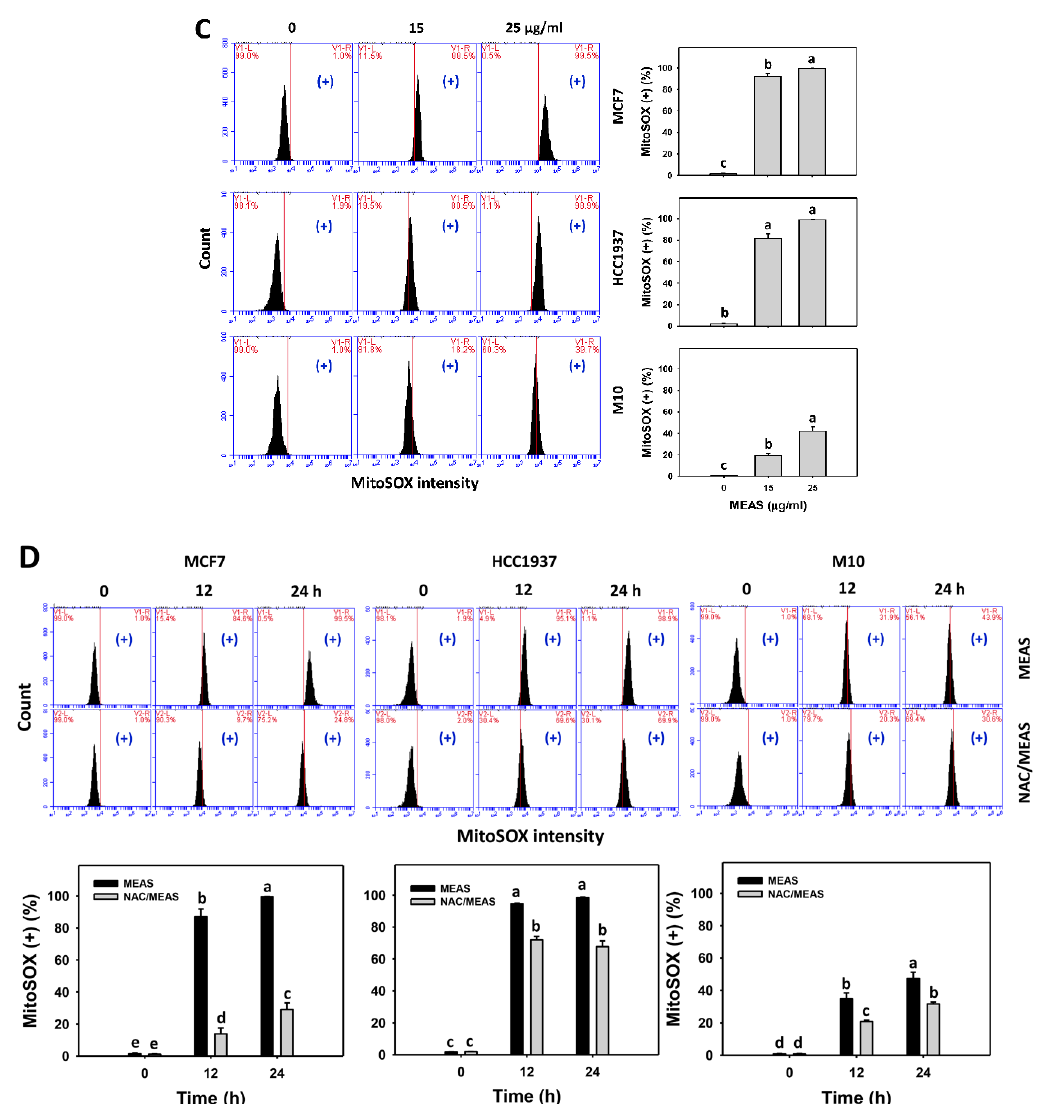
Figure 6. MEAS increased ROS and MitoSOX intensities of breast cancer cells. ( A , C ) ROS and MitoSOX assays of MEAS. Except for normal breast cells (M10), others were TNBC and non-TNBC cells. Flow cytometry was performed after 24 h drug treatment. (+), inserted within each panel, indicates the ROS and MitoSOX (+) intensity. ( B , D ) ROS and MitoSOX assays o f NAC/MEAS. NAC/MEAS represents NAC pretreatment (10 mM, 1 h) and MEAS posttreatment for 0, 12, and 24 h. Data = mean ± SD ( n = 3). Statistical software assigned low-case letters to each treatment.